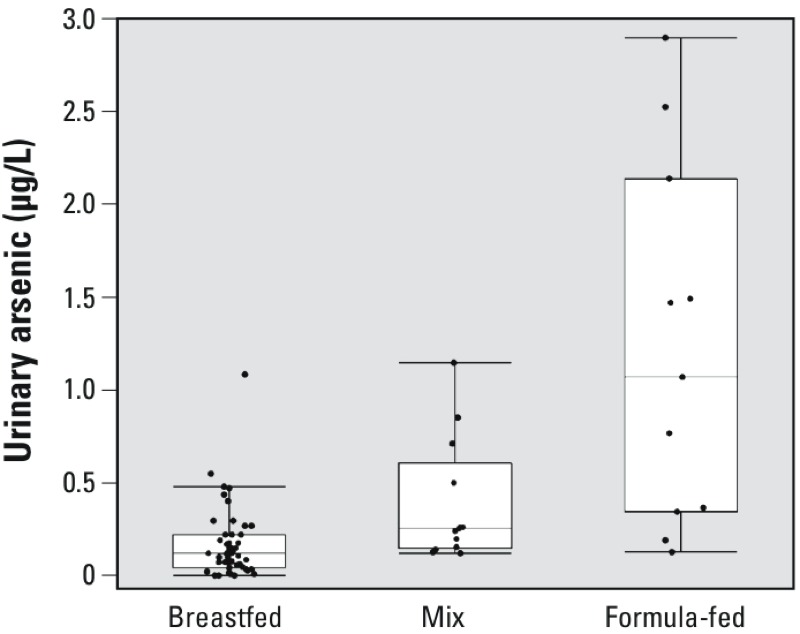
Urinary arsenic (total arsenic minus arsenobetaine, not adjusted for specific gravity) in approximately 6‑week‑old infants by predominant feeding mode: exclusively breastfed (n = 48), mixed (n = 13), and exclusively formula-fed (n = 11). Boxes represent quartiles, the lines within the boxes represent the median, and each whisker represents the quartile ± 1.5 times the interquartile range. Dots represent individual results.